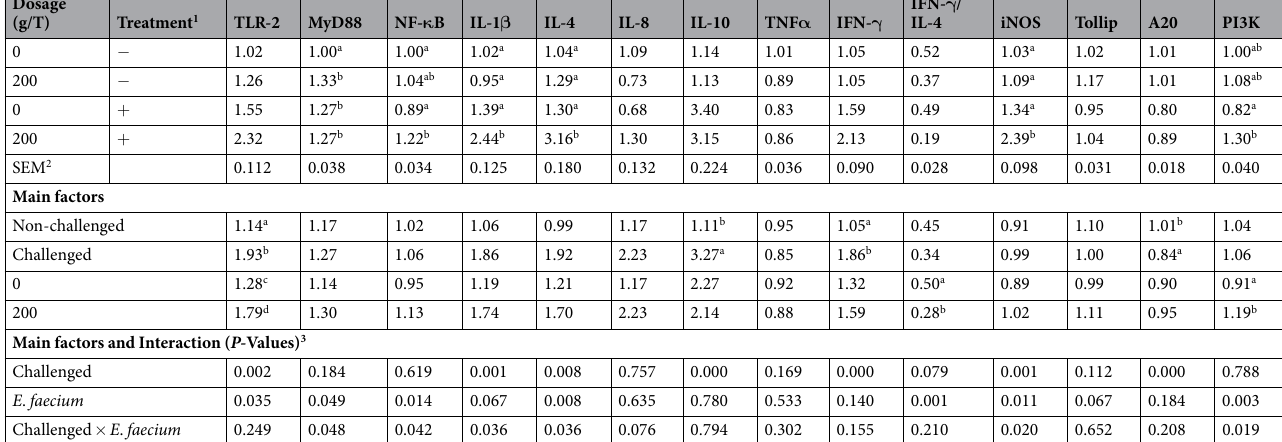
Table 2. Effect of dietary E . faecium 11181 on mRNA expression of TLR signaling pathway-related genes and downstream cytokines (on d 26, 7 DPI) in the jejunum of broiler chickens challenged with NE. a,b,c,d Means in the same column without common superscripts differ significantly (P < 0.05). 1 Co-challenged with Eimeria spp. and C. perfringens ; -, without NE challenge; + , with NE challenge. 2 SEM, standard error of the mean. 3 P -value represents the main effect of the diet, the main effect of NE challenge, and the interaction between the dietary treatments and NE challenge.